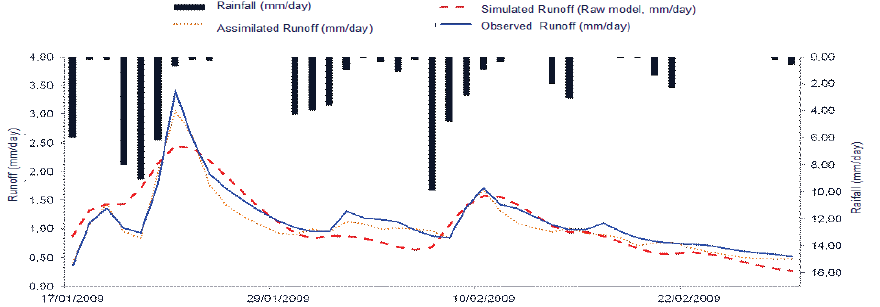
Fig. 3 Evolution of streamflow predicted (fine dished line) compared to those obtained with HBV simulation (bold dished line) and observed streamflow (continuous line) at the outlet of the Serein for the observed period 17 January 2009 to 27 February 2009 with 3 days assimilation and 1 day forecast lead time. SW, STW1, STW2 and STW3 are updated with assimilation (HBV without assimilation Nash = 0.70, Assimilated flow Nash = 0.93. Table 1 Comparison of peak flows (occurrence, amplitude and timing) of stream flow forecasted with 3 assimilation and 1 day forecast lead time, to those obtained with HBV simulation with the observed stream flow at the outlet of the Serein, for the observed period of 17 January 2009 to 4 March 2009. Simulated flow without assimilation (Raw